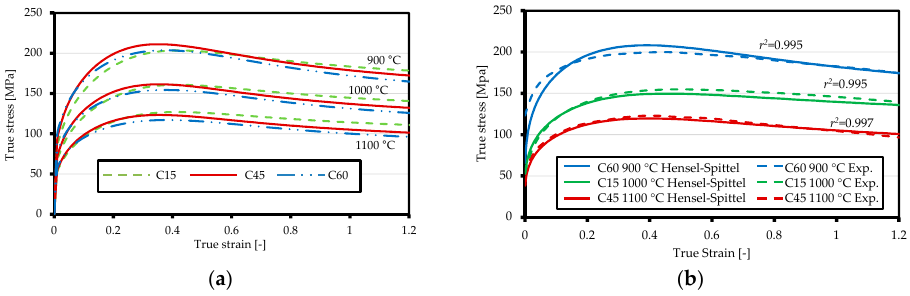
Figure 5. Calculated flow curves for the steel grades C15, C45, and C60 at different temperatures (900 °C, 1000 °C, 1100 °C) and a strain rate of 10 s − 1 ( a ) Comparison between experimentally-measured and calculated flow curves for the steel grades C15, C45, and C60 at different temperatures and a strain rate of 10 s − 1 ( b ).